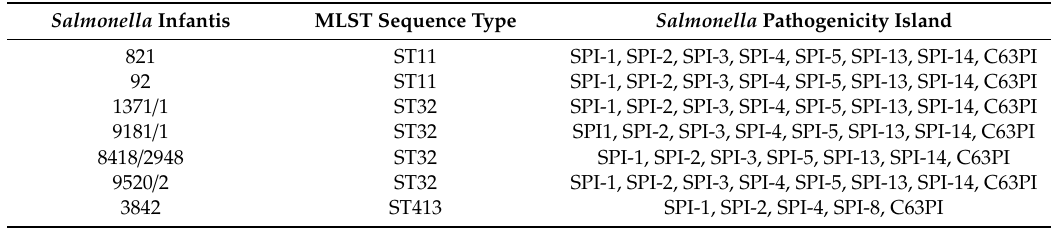
Table 3. Salmonella pathogenicity islands of seven S . Infantis colistin-resistant isolates from